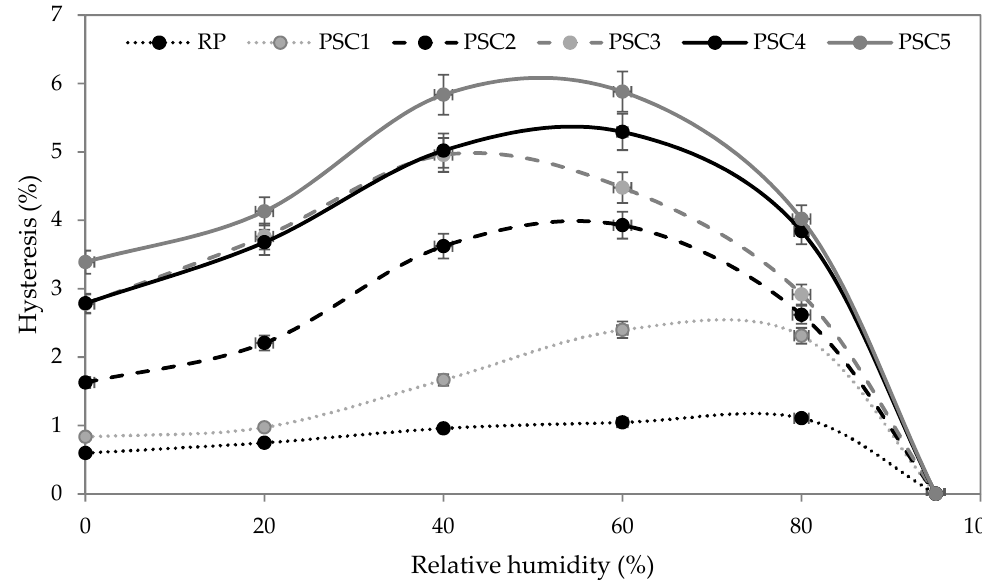
Figure 7. Water vapor hysteresis of studied plasters at 20, 40, 60, 80 and 95% RH.